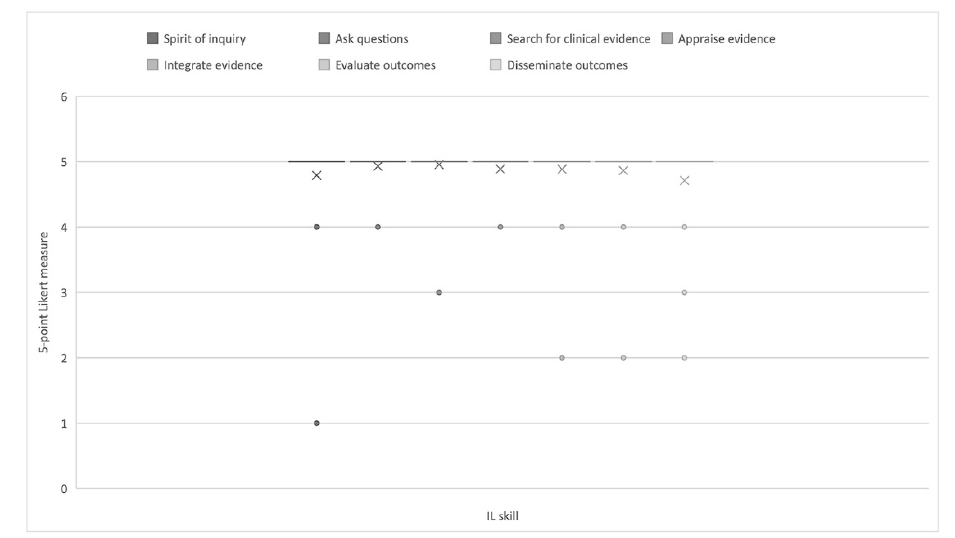
Figure 5 Nursing faculty ratings of the relevance of IL skills at the doctor of nursing (DNP)